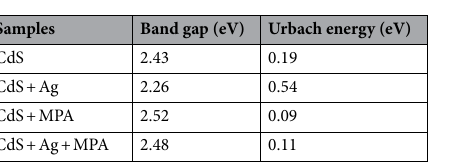
Figure 3. Urbach energy determined for the CdS thin films; ( a ) Basic CdS, ( b ) CdS + Ag, ( c ) CdS + MPA, ( d ) CdS + Ag + MPA.